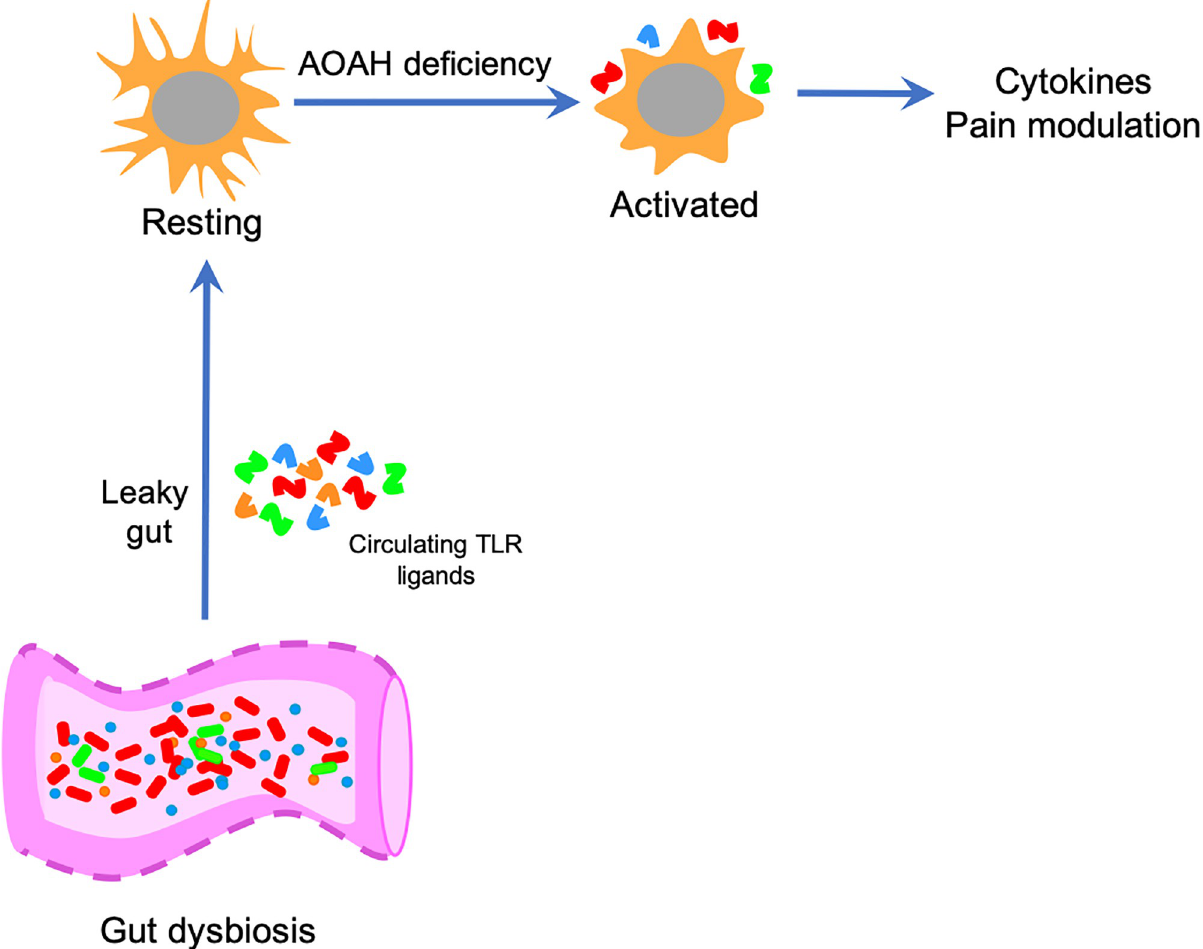
Fig 6. Role for AOAH in microglial activation. At baseline, microglia exhibit a ramified/resting phenotype. AOAH deficiency results in microglia with an activated phenotype. Microglial activation associated with AOAH deficiency could arise in direct response to circulating microbial ligands that the gut crossing the blood brain barrier and activating microglia, or through indirect mechanisms including enhanced CRF signaling, vagus nerve signaling to the CNS, or intrinsic hyper-responsiveness due to loss of AOAH-mediated arachidonic acid homeostasis. Prolonged microglial activation then modulates pelvic